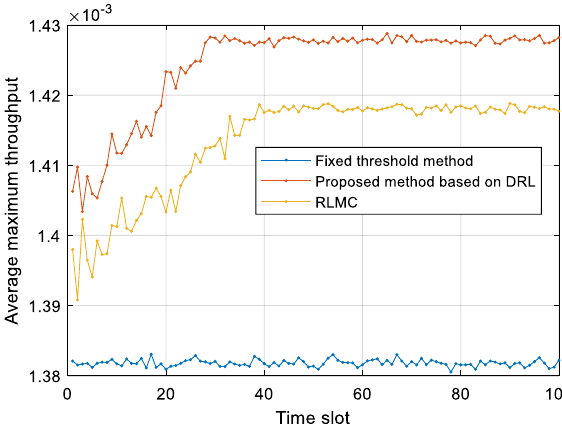
Fig. 17 Average maximum throughput of each time slot in simulated